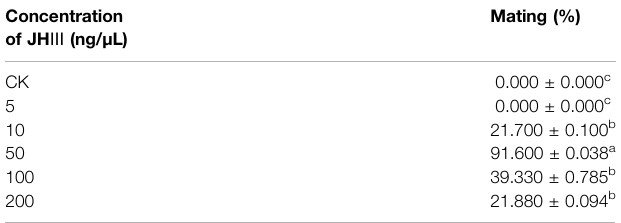
The data in the table are mean ± SE. The different lowercase letters in the upper right corner represent a signi fi cant difference at p < 0.05 (one-way ANOVA followed by Duncan ’ s multiple comparison).